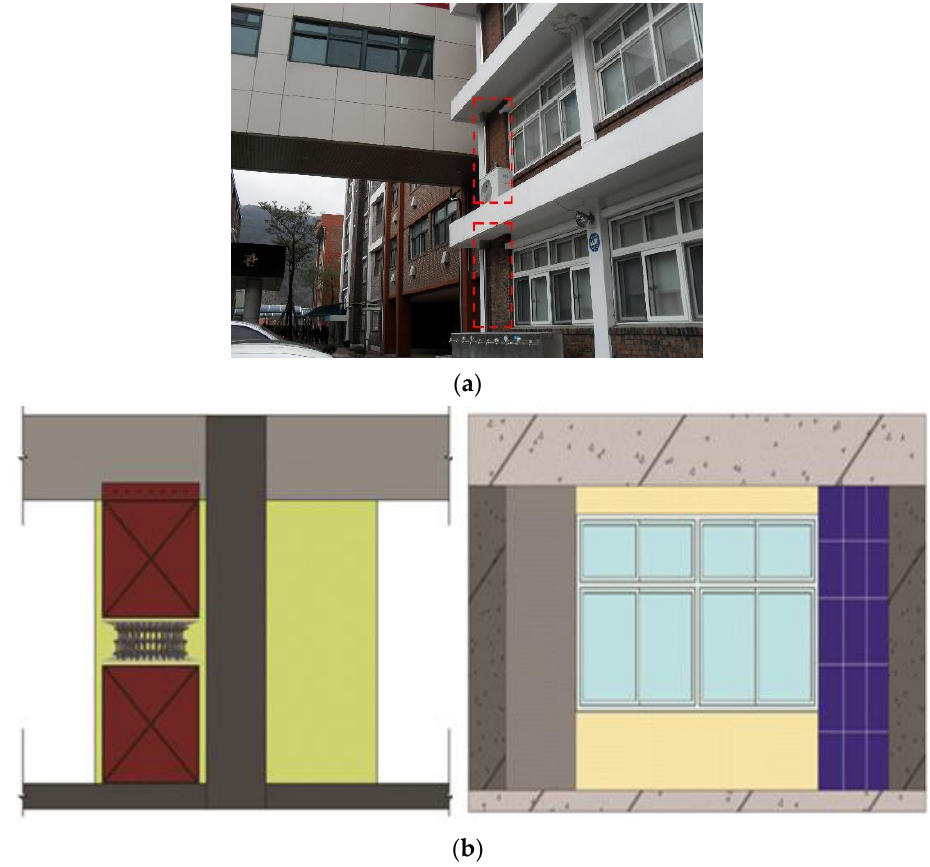
Figure 4. Wall-type Kagome damping system. ( a ) WKDS installation location, ( b ) WKDS construc- tion.